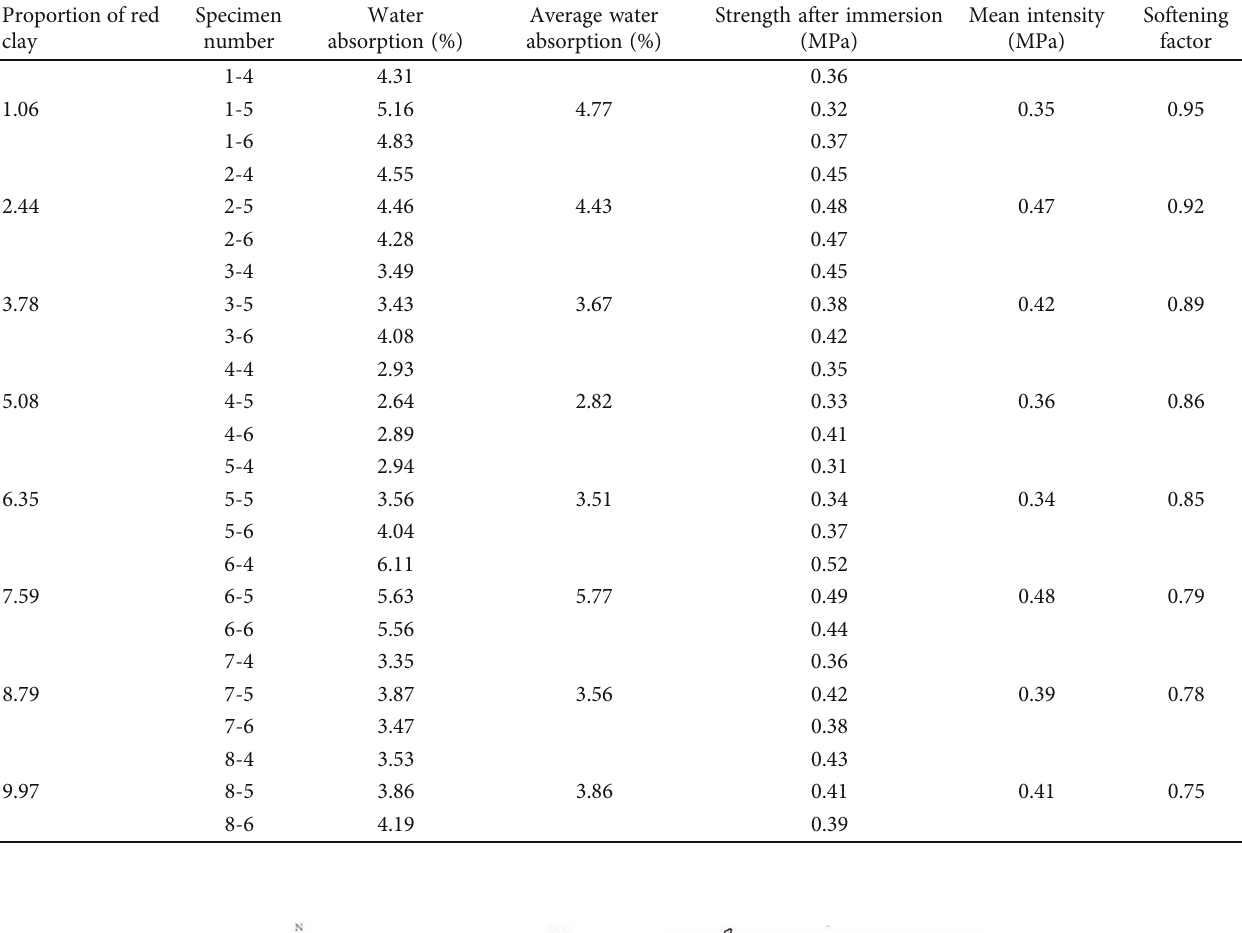
Table 5: Water absorption and softening coe ffi cient of similar materials after immersion in water.